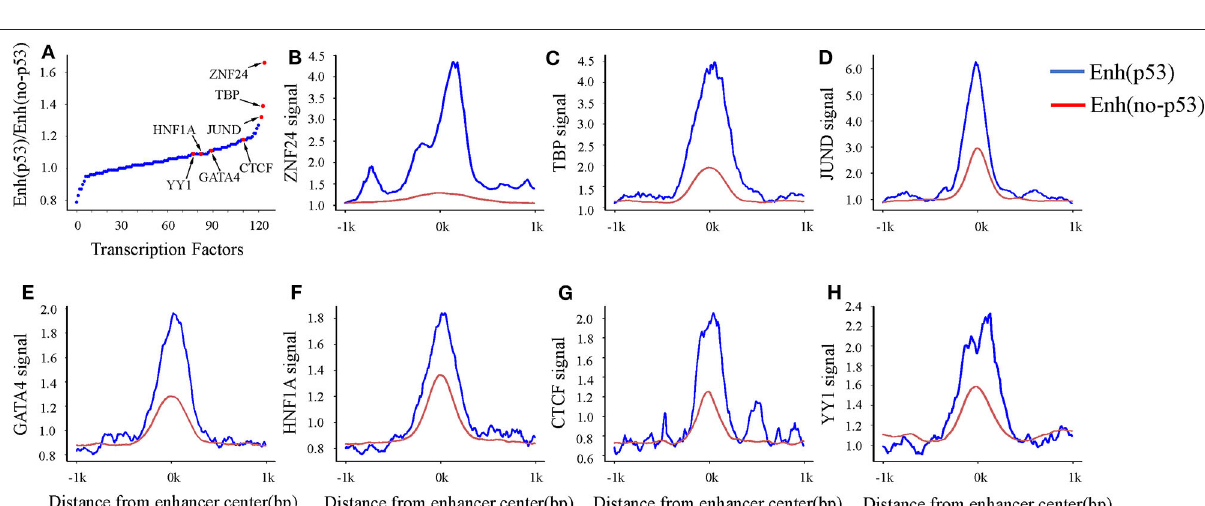
FIGURE 3 | TF binding on Enh p53 and Enh no 1kb upstream and downstream of the enhancer. (B–H) TF binding signals located in the region of